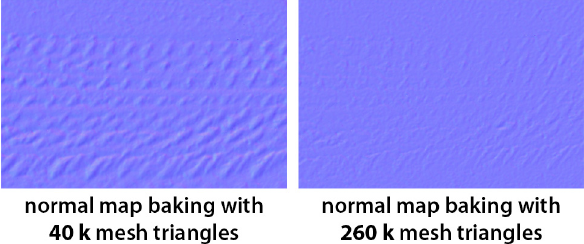
Figure 7. Tangent space normal map baking from low-poly meshes with different amounts of triangular